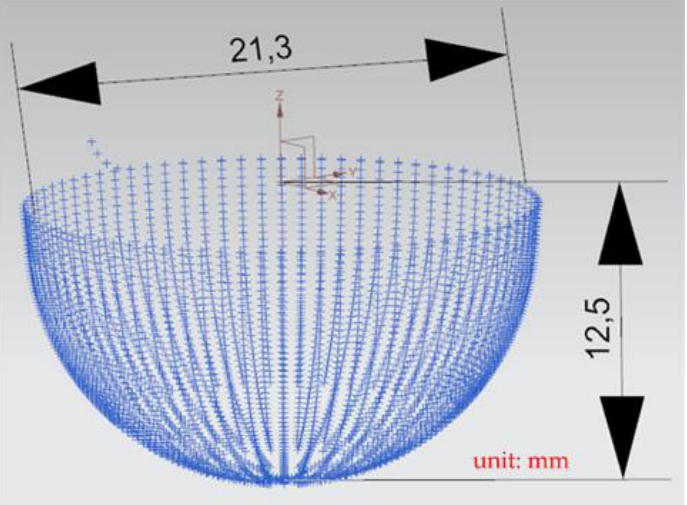
Figure 17. Spatial diagram of original concave circle finish machining.